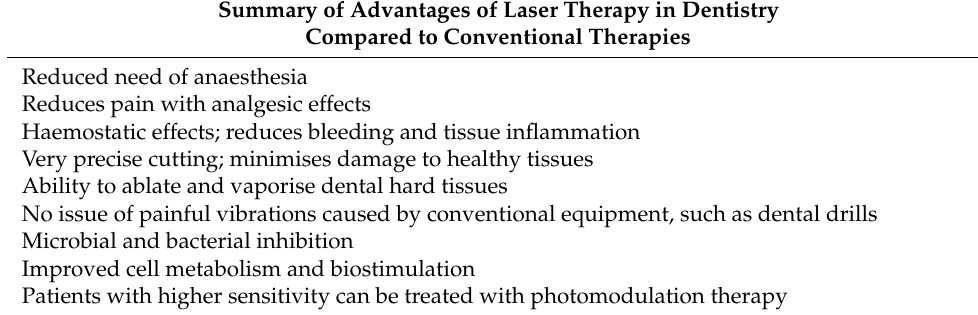
Table 2. Summary of advantages of laser therapy in dentistry compared to conventional therapies.